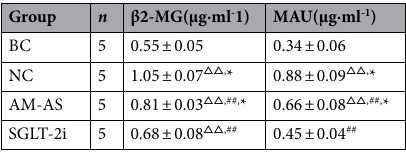
Table 6. Medical laboratory examination of urine( X ± S ). △△ P < 0.01 vs. BC, ## P < 0.01 vs. NC, * P < 0.05 vs. SGLT-2i.